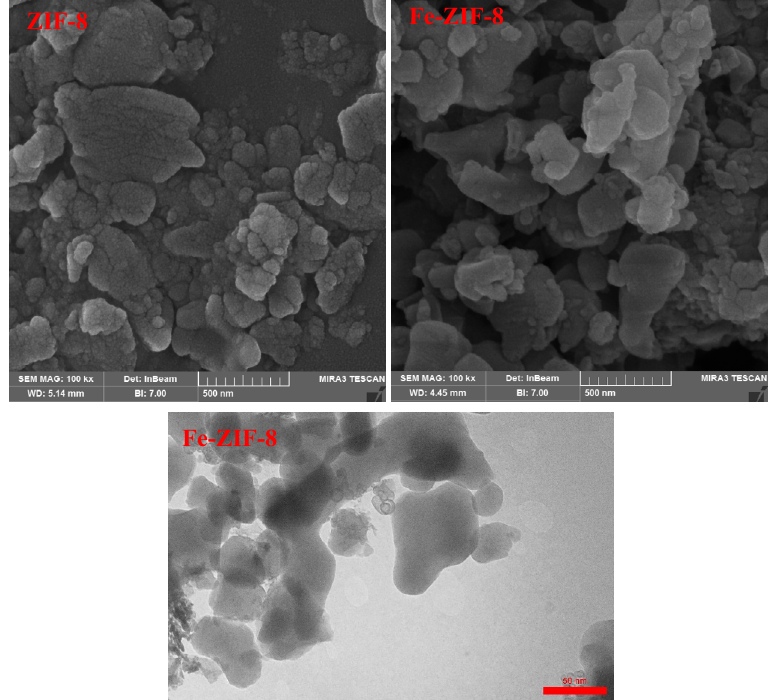
Fig. 4. FE-SEM and TEM images of the